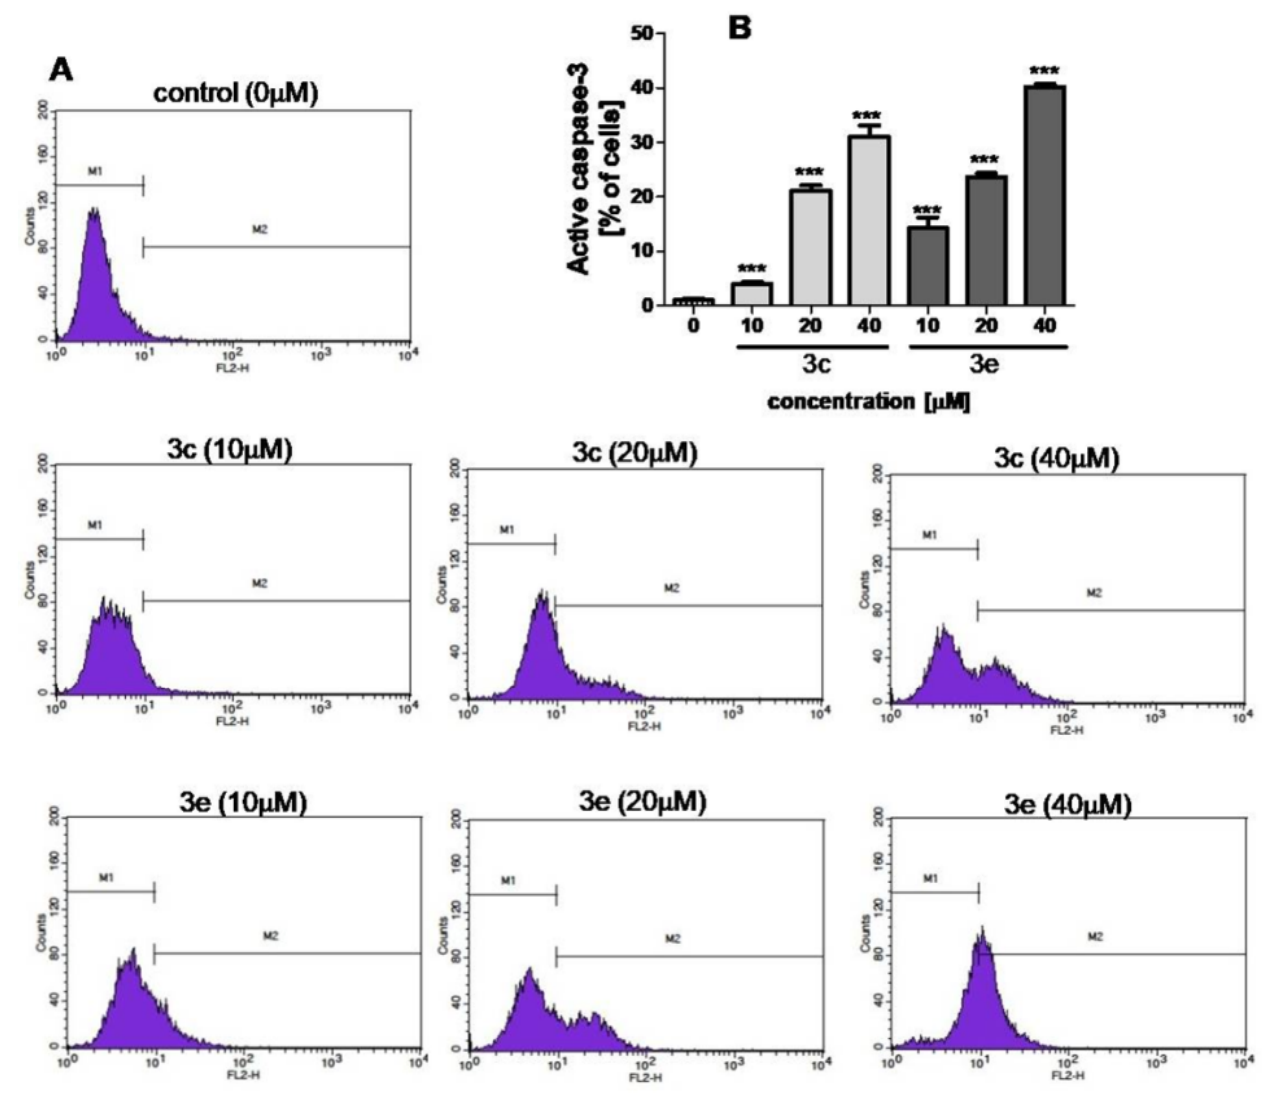
Figure 5. Flow cytometry analysis of active caspase-3 in A549 cells treated with compounds 3c and 3e for 48 h. ( A ) Representative histograms of A549 cell culture — M1 and M2 gates represent peaks for viable (caspase-3 negative cells) and apoptotic cell fractions (caspase-3 positive cells detected after cell staining with PE-conjugated anti-active caspase-3 antibodies), respectively. ( B ) Quantifi- cation of caspase-3 activity in A549 cell culture. The results are mean values ± SD of three inde- pendent experiments; statistical significance at p < 0.001 *** in comparison to the control; one-way ANOVA followed by Dunnett’s post hoc test.